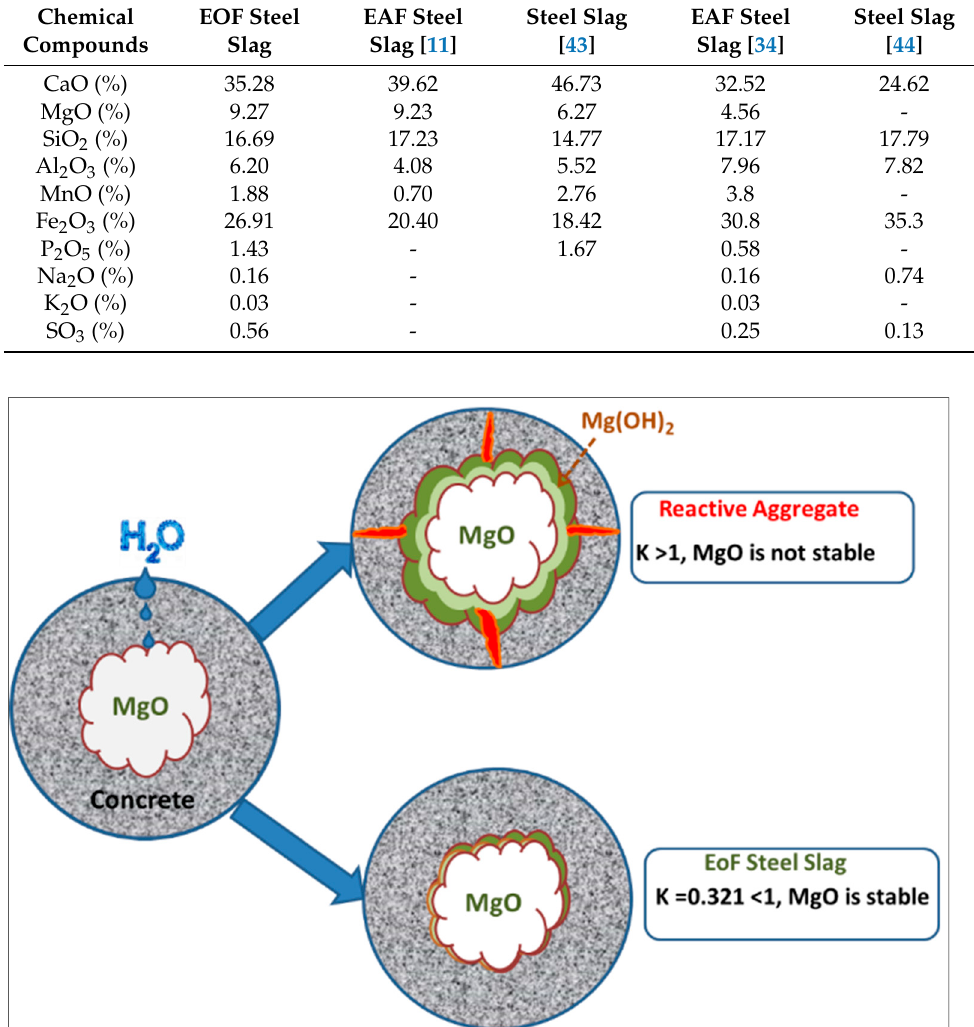
Figure 9. Stable Mechanism of Magnesium Oxide in EOF steel slag.